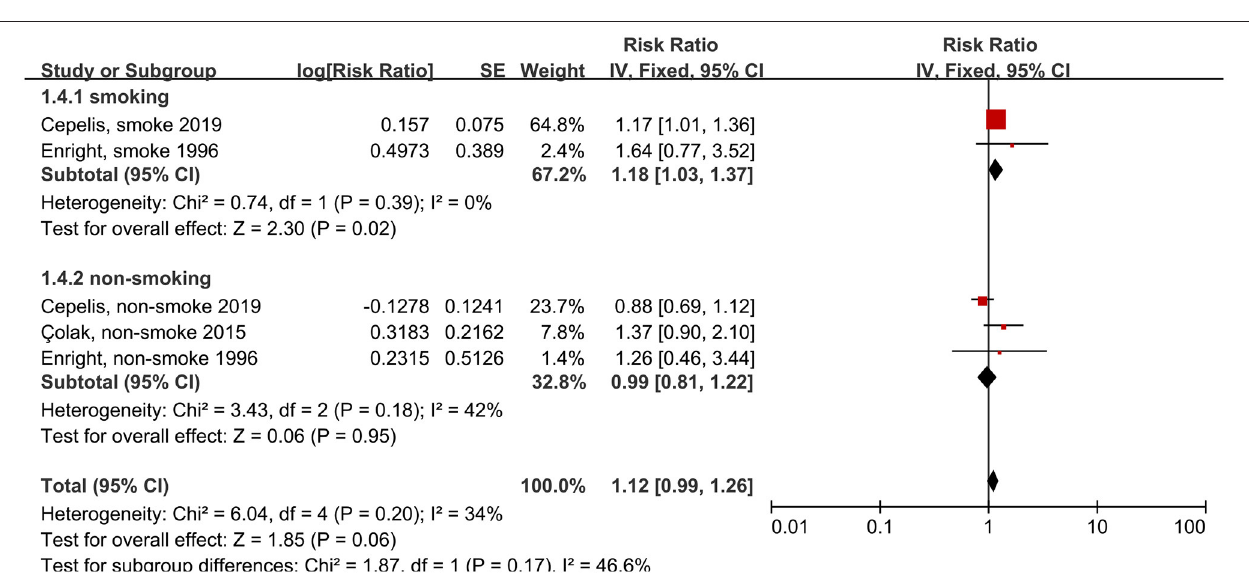
FIGURE 5 | Forest plot shows association between asthma and the risk of stroke in smoking or non-smoking people. SE, standard error; IV, Inverse Variance method; df, degrees of freedom.